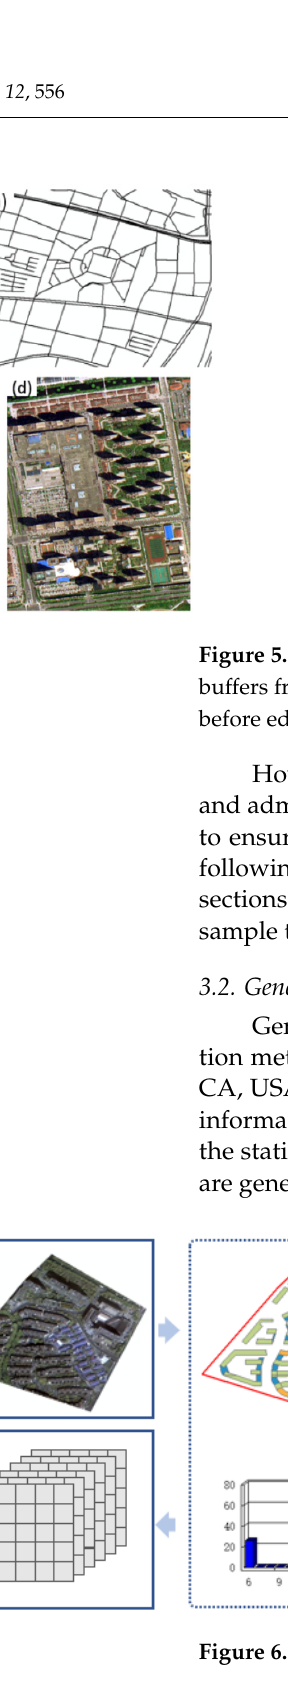
Figure 6. Generation of the footprint feature tensor.